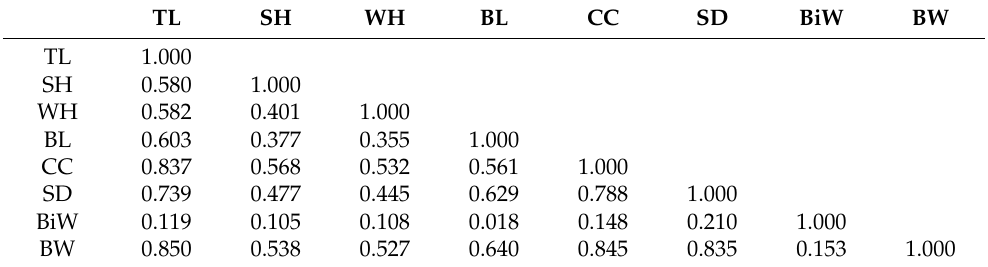
Table 2. Correlation